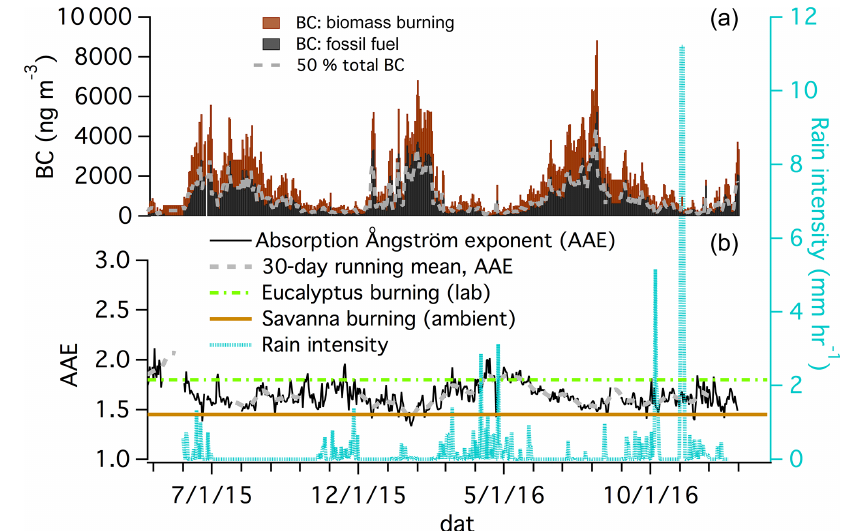
Figure 7. (a) Time series of contributions of fossil fuel combustion and biomass burning to BC concentrations observed at RCO. (b) Daily average absorption Ångström exponent (AAE) measured at RCO (black line) with rain intensity and published AAE for Eucalyptus burning (Yuan et al., 2016); laboratory studies (green line) and savanna burning (Russell et al., 2010; ambient, brown line) are also shown as reference.